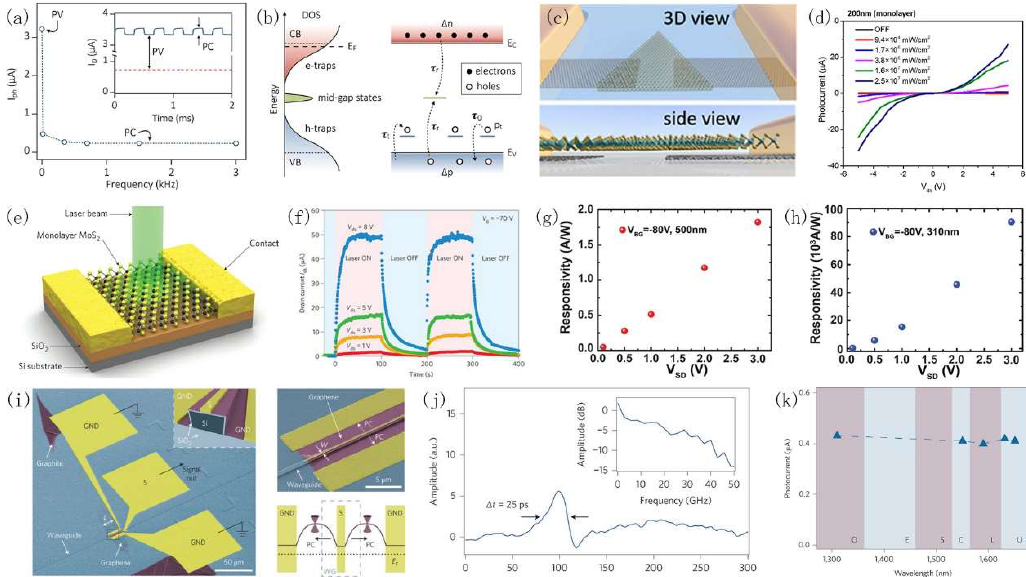
Figure 5. Single-channel photodetector. ( a ) Photocurrent induced by photovoltaic effect and photoconductive effect as function of modulation frequency [100]; ( b ) Schematic diagram of charge-trapping assisted photo detection [100]; ( c ) Schematic view and ( d ) photocurrent vs. drain bias of a graphene/WS 2 /graphene photodetector [110]; ( e , f ) Schematic structure and the time-resolved photo response of single-channel MoS 2 photodetector [10] ( g , h ) Photo responsivity of monolayer MoS 2 photodetector with different wavelength of light [117]; ( i ) Schematic of waveguide integrated graphene photodetector and band diagram [104]; ( j ) Very fast response with △ t = 25 ps [104]; ( k ) Stable photo current across all optical telecommunication windows [104].